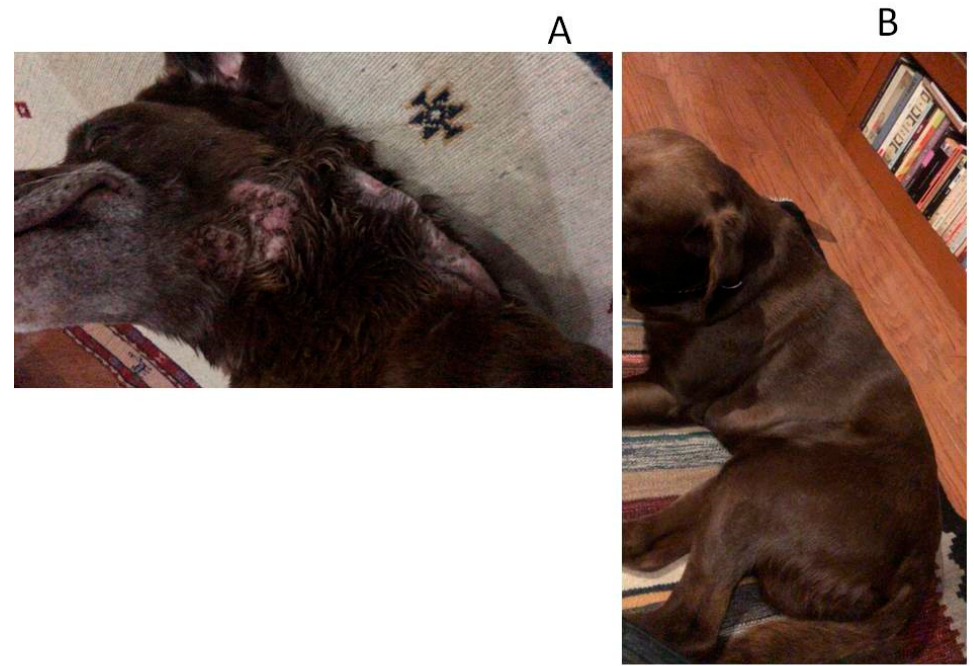
Figure 2. Canine unresponsive deep-pyoderma, classified as severe, and treated with enrofloxacin HCl-2H 2 O (enro-C) at a dose of 10 mg/kg orally in gelatin capsules, plus the topical administration thrice a day of enro-C prepared as gel. Aspects of the disease in a dog at admission ( A ) and after treatment ( B ).